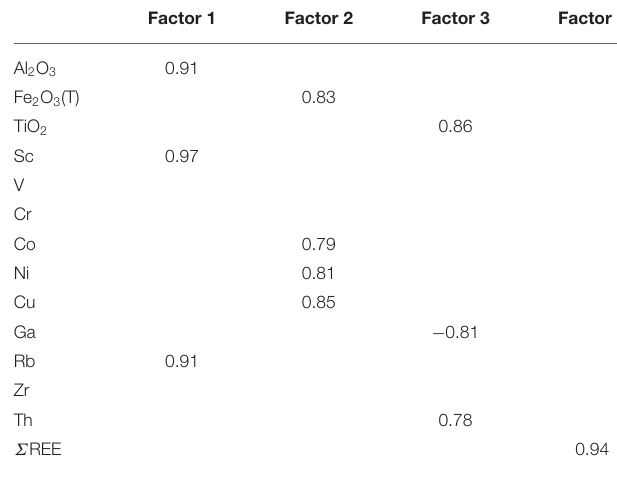
TABLE 3 | R-mode factor analysis results for the MP